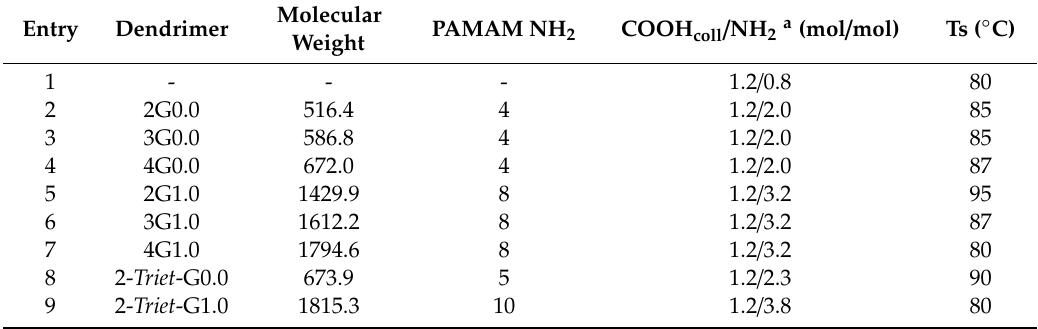
Table 1. E ff ect of PAMAM auxiliaries on the Ts of bovine collagen powder cross-linked with EDC /